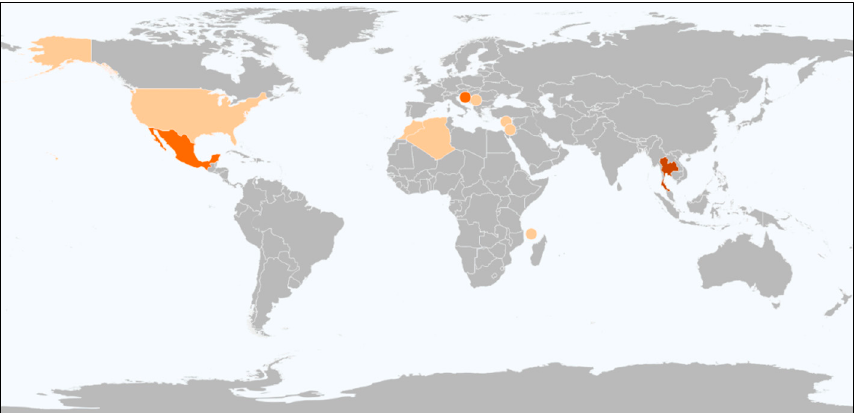
Figure 2. Distribution of contributions to the Special Issue. Colored countries are represented in the Special Issue; color shade represents the number of contributions from a country (light—1, dark—3).